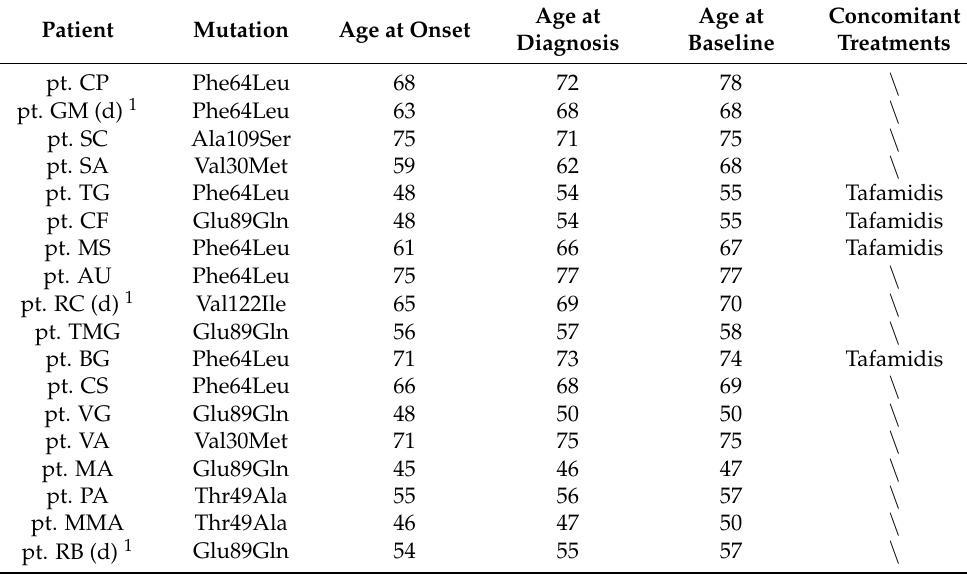
Table 1. Demographics, genotypes and concomitant